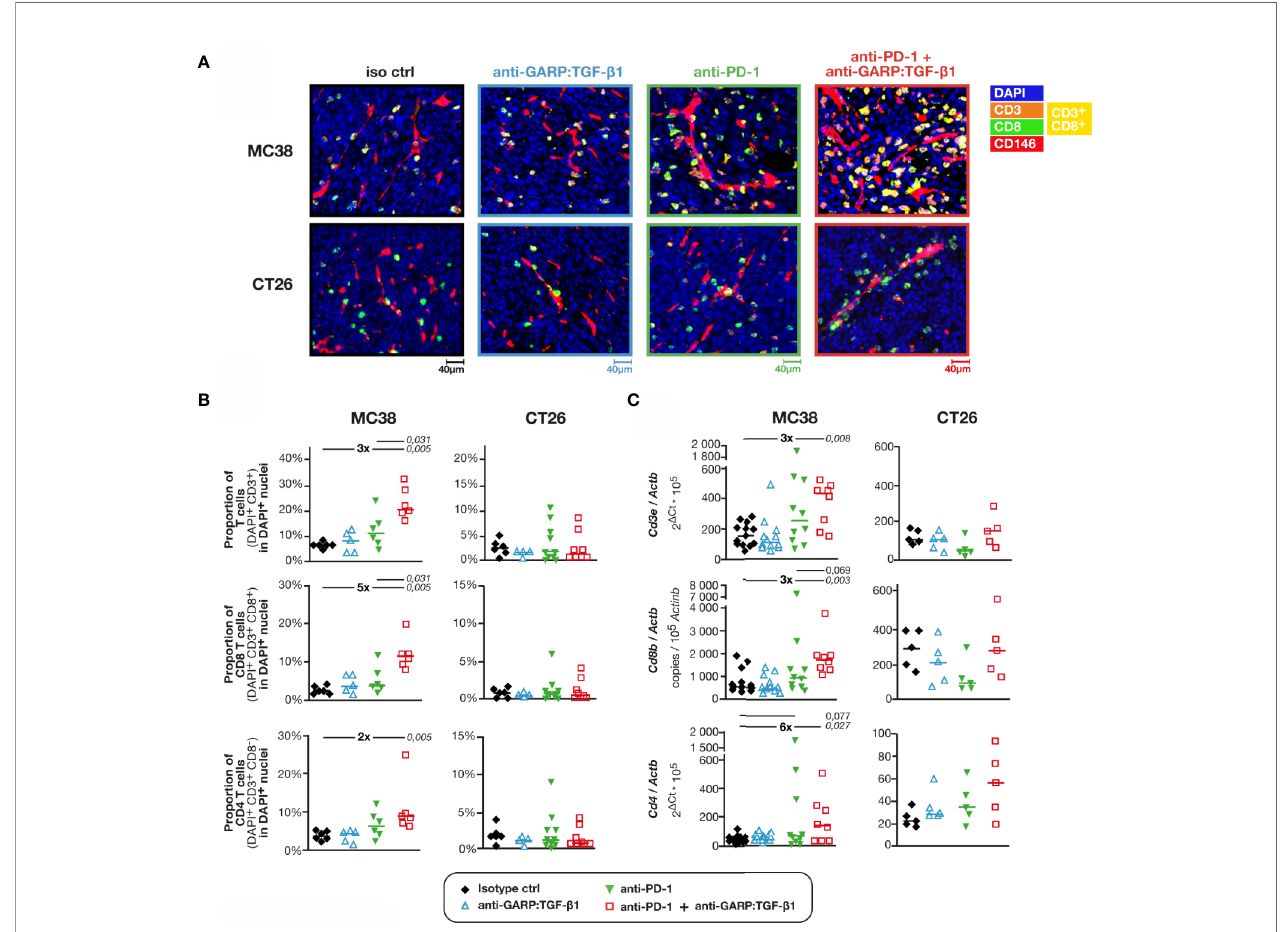
FIGURE 1 | Combined GARP:TGF- b 1/PD-1 blockade increases in fi ltration of total, CD8 and CD4 T cells in MC38, but not in CT26 tumors. C57BL/6 or BALB/c mice were injected on day 0 with live MC38 or CT26 cells, respectively, and treated on days 6, 9 and 12 with anti-GARP:TGF- b 1 (clone 58A2 mIgG1 in C57BL/6 mice; clone 58A2 mIgG2a DANA in BALB/c mice), anti-PD-1 (clone RMP1-14 mIgG2a FcSilent), a combination of both mAbs or the corresponding isotype controls. Tumors were collected on day 13 and fragments were analyzed by mIF and quantitative digital imaging or RT-qPCR. (A) Representative images of FFPE tumor sections stained with anti-CD3 antibody (orange), anti-CD8 antibody (green), anti-CD146 antibody (red) and Hoescht (DAPI, blue). CD8 T cells (CD3 + CD8 + ) appear in yellow. (B) Proportions (%) of total, CD8 and CD4 T cells in DAPI + nuclei measured with Indicalabs Halo software. Results obtained in one experiment for MC38 (n = 5 – 6 mice/group) and pooled from two independent experiments for CT26 (n = 3 – 6 mice/group in each experiment). One tumor section analyzed per mouse. (C) Expression levels of Cd3e , Cd8 and Cd4 mRNA relative to housekeeping gene Actb in MC38 and CT26 samples. Samples from two independent experiments for MC38 (n = 4 – 7 mice/group in each experiment) and one experiment for CT26 (n = 5/group). Samples from the second MC38 experiment shown in c were also analyzed in Figure S2 by fl ow cytometry. Data points represent values in individual mice. Horizontal bars: median per group. P values <0.05, calculated with a two- sided Wilcoxon test, are indicated in italics. Numbers in bold: fold-change between the indicated